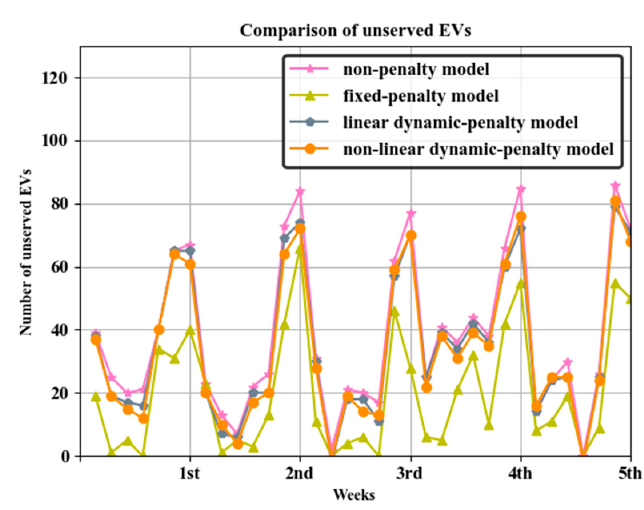
Figure 12. Comparison of unserved EVs. Table 6. Comparison of indicators under the three optimized